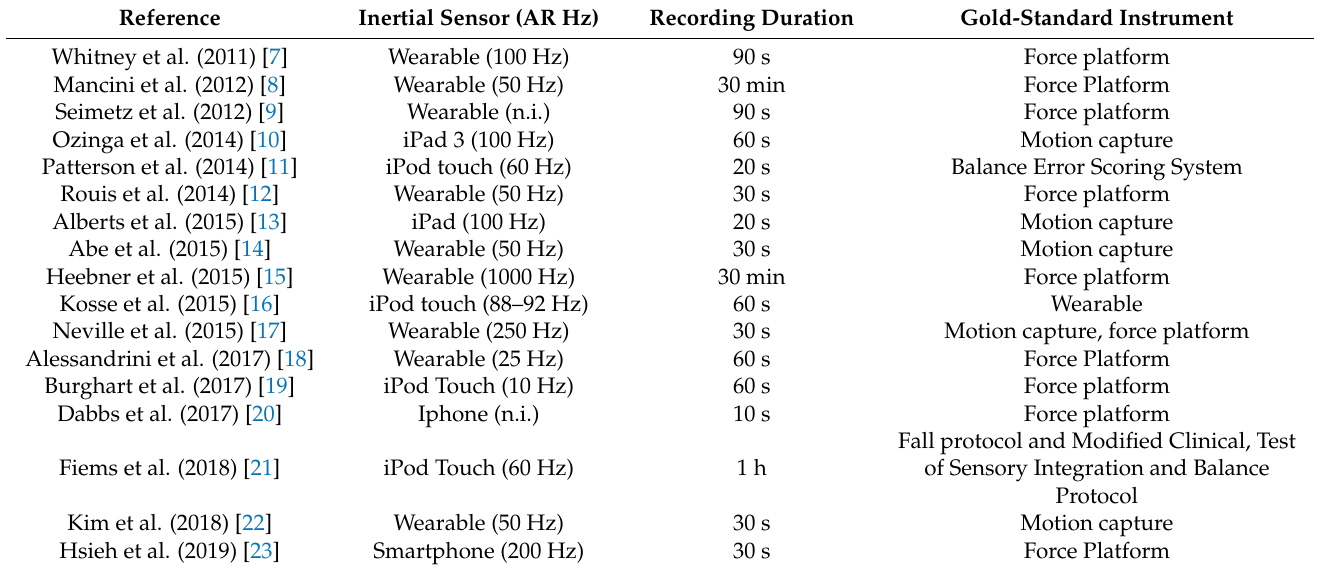
Table 1. List of references that validated inertial sensors for balance assessment.